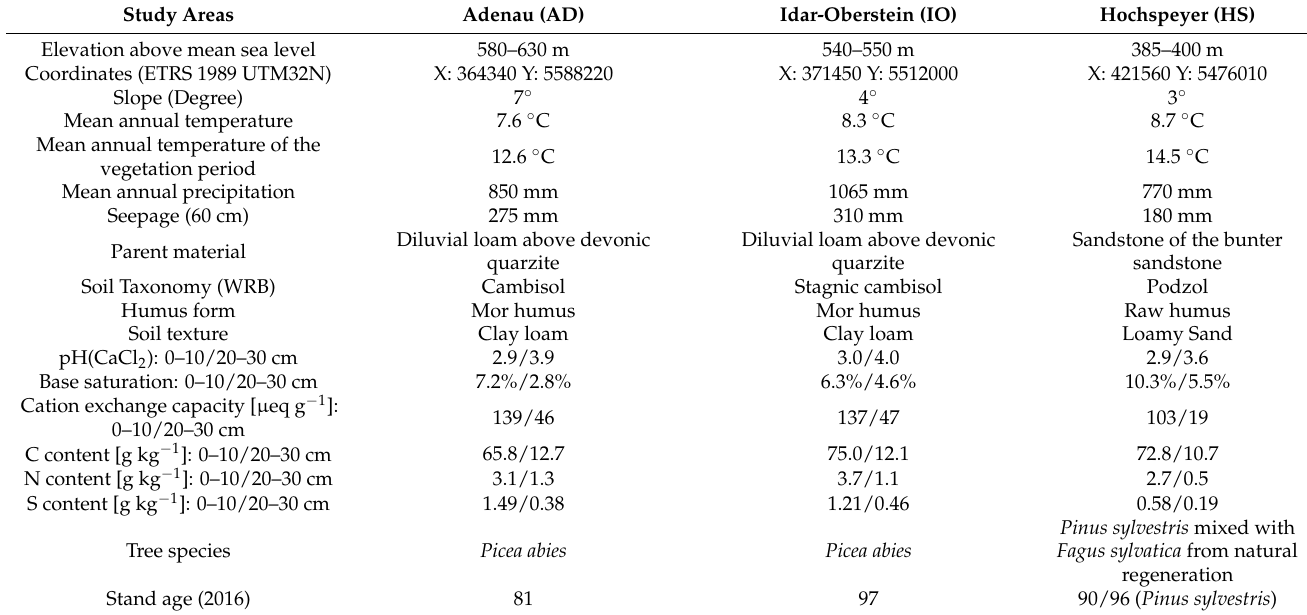
Table 1. Information about the three experimental sites. More detailed Information is available in Greve [22].